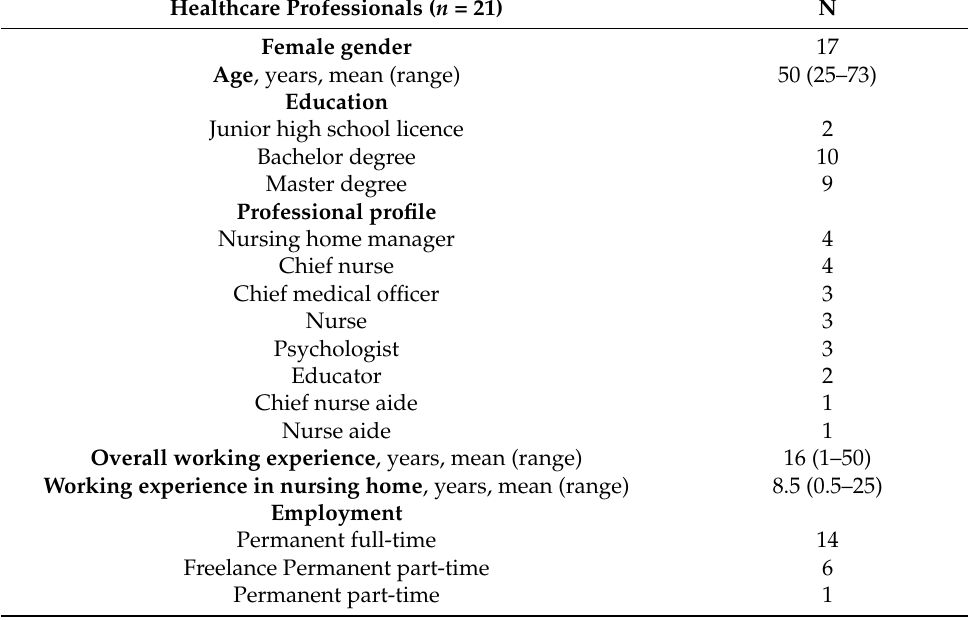
Table 2. Participants’